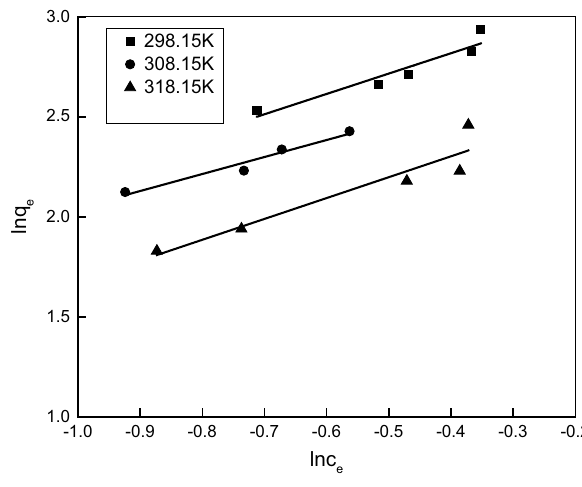
Fig. 13 Freundlich adsorption isotherm equation fitting diagram